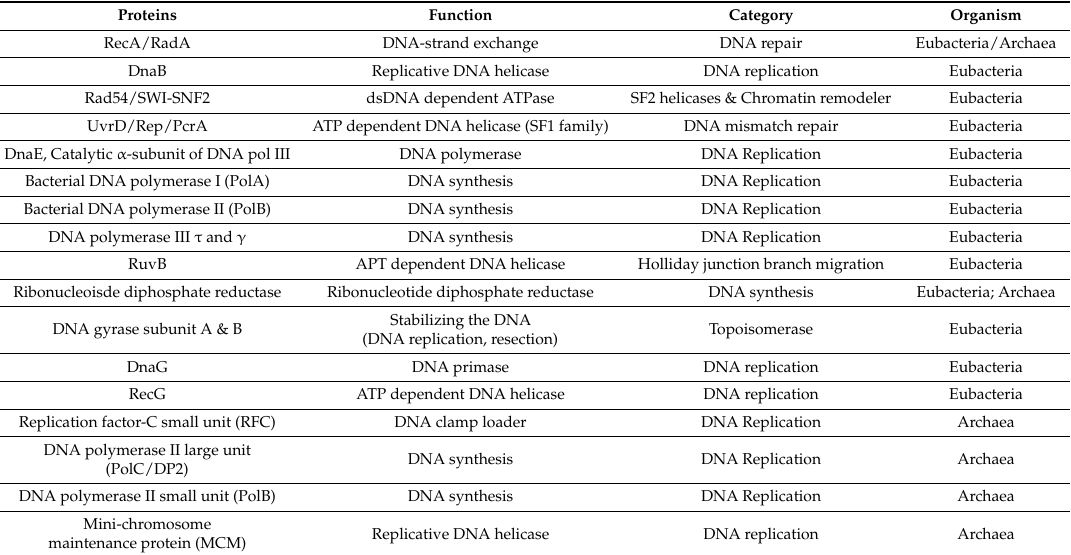
Table 1. Some of the intein-containing proteins involved in the DNA replication, recombination, and repair process. Proteins Function Category Organism